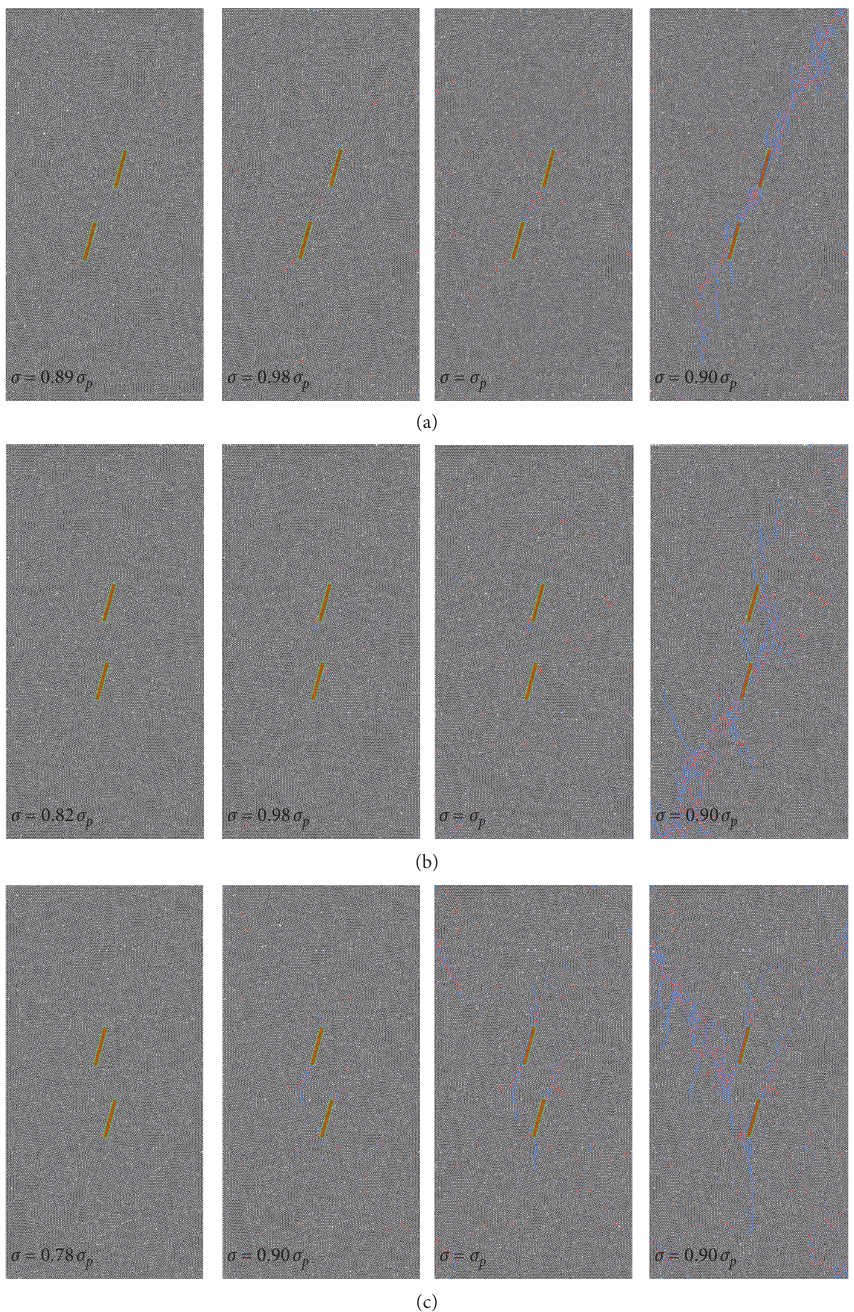
Figure 10: Crack development process of samples containing infilled flaws with the same α of 75 ° and different β of 60 ° , 90 ° , and 120 ° (blue cracks represent tensile cracks and red cracks represent shear cracks). (a) α � 75 ° and β � 60 ° , (b) α � 75 ° and β � 90 ° , (c) α � 75 ° and β � 120 °